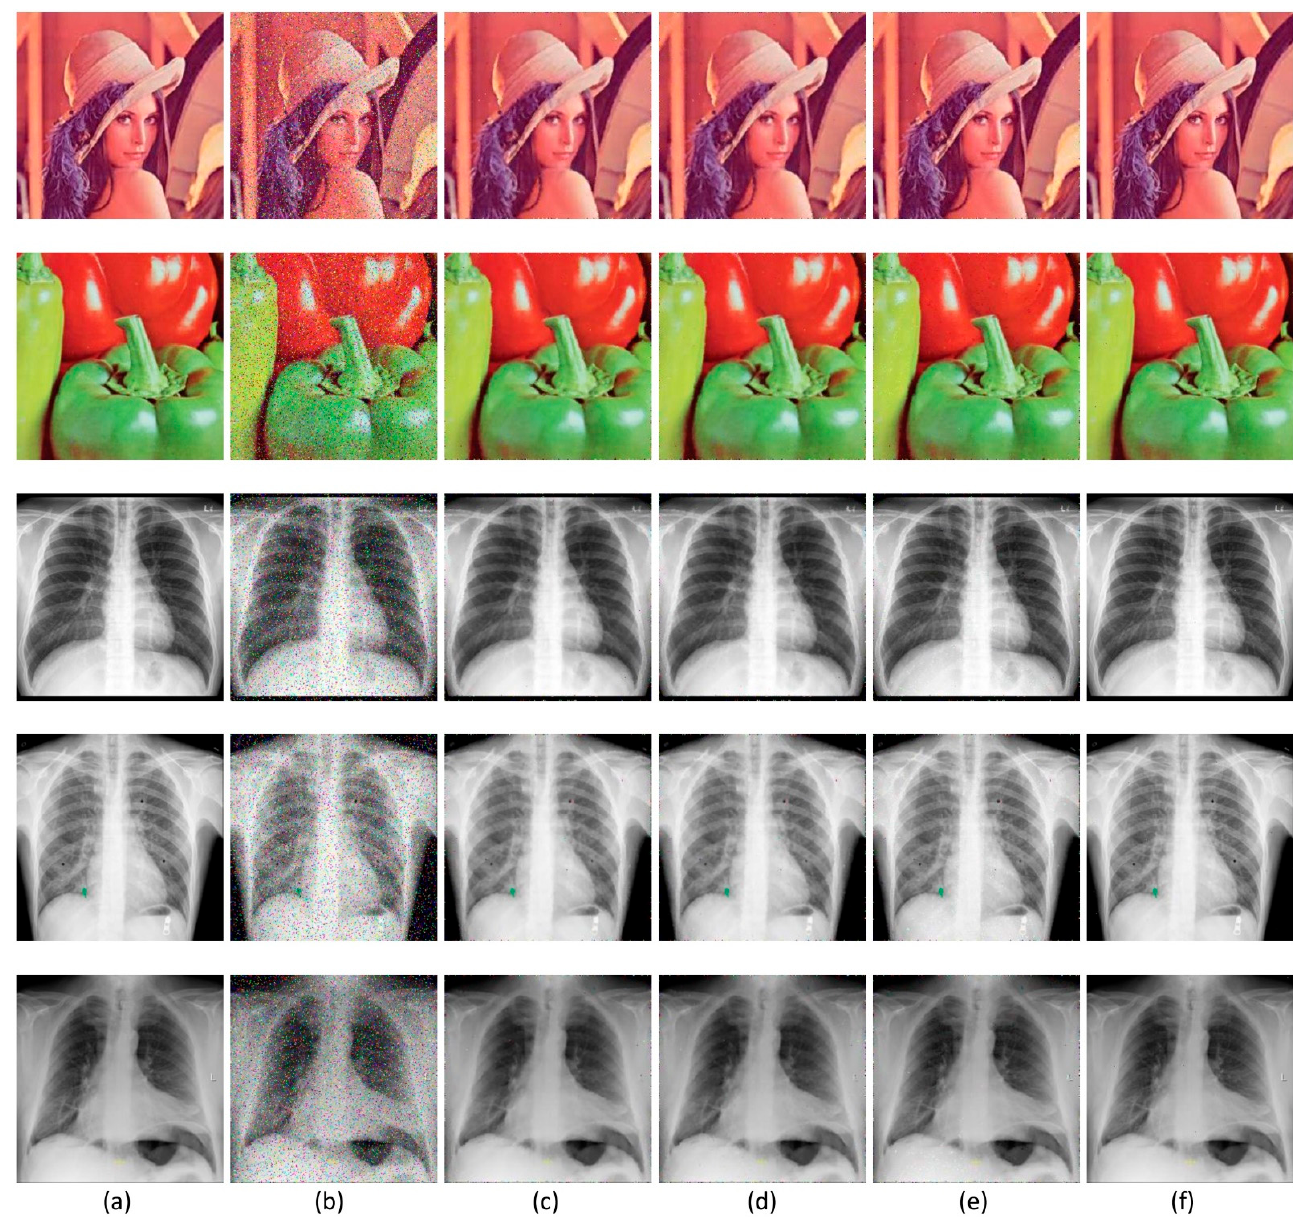
Figure 6. ( a ) Original images. ( b ) Corrupted images with 10% impulsive noise. Filtered images using ( c ) VMF, ( d ) VMRHF, ( e ) MSMF, and ( f ) MLVMF filters.